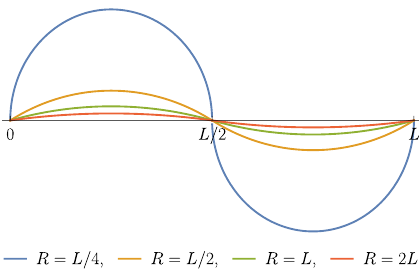
Figure 4 . The modulation of the periodic piecewise circle with the radius R and the period L . The maximum amplitude of the modulation is given by f ( L/ 4) ’ L 2 / 32 R for R (cid:29) L